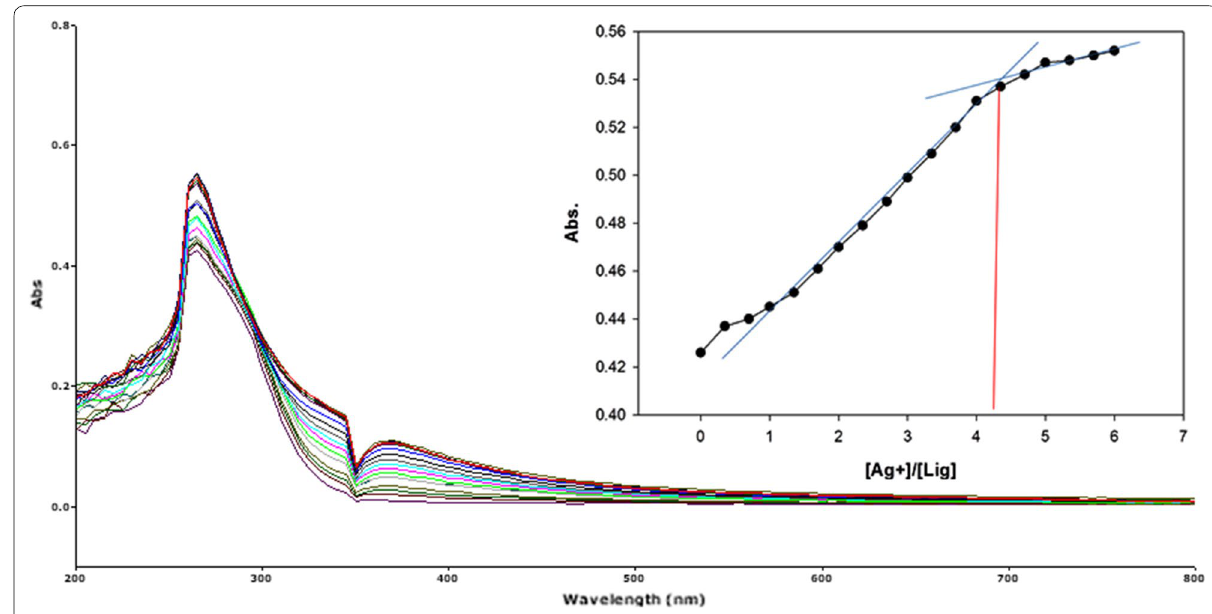
Fig. 17 Titration of isomer 1B vs Ag + ( Inset Binding behavior